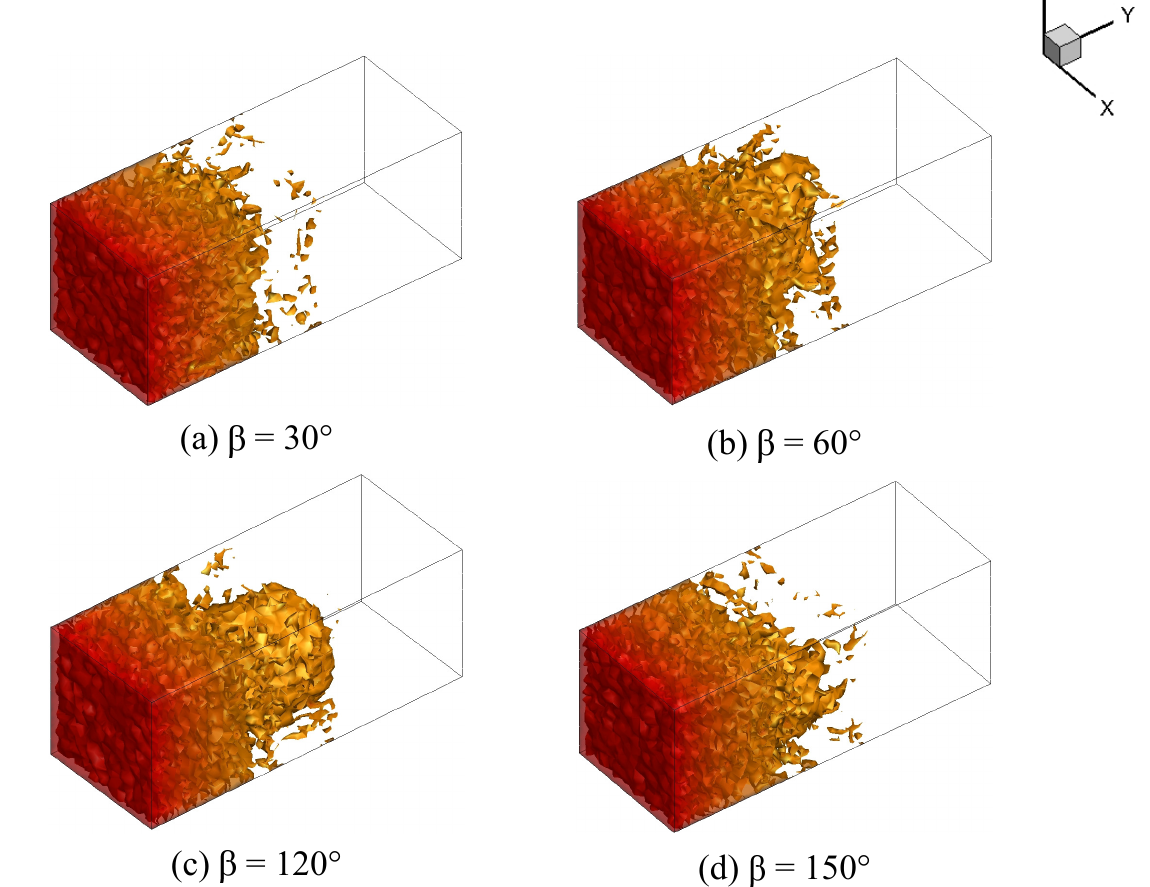
Figure 11. Grout penetration with a single fracture with different dip directions in the porous medium considering the filtration